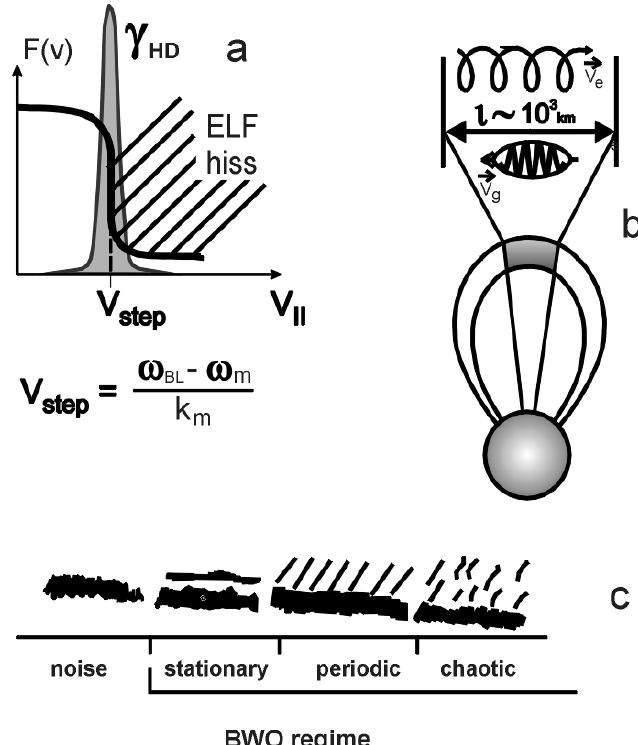
Fig. 1. (a) A schematic picture of a specific step-like deformation of the distribution function by cyclotron interactions of a natural ELF/VLF noise-like emissions and energetic electrons. This step-like deformation of energetic electron distribution function ensures the large growth rate of the whistler waves and transition to the BWO generation regime, which forms a succession of discrete signals. (b) Schematic picture of the BWO generation regime for chorus generation in the magnetosphere. (c) Dynamic spectra of VLF emissions, corresponding to different regimes of the magnetospheric BWO